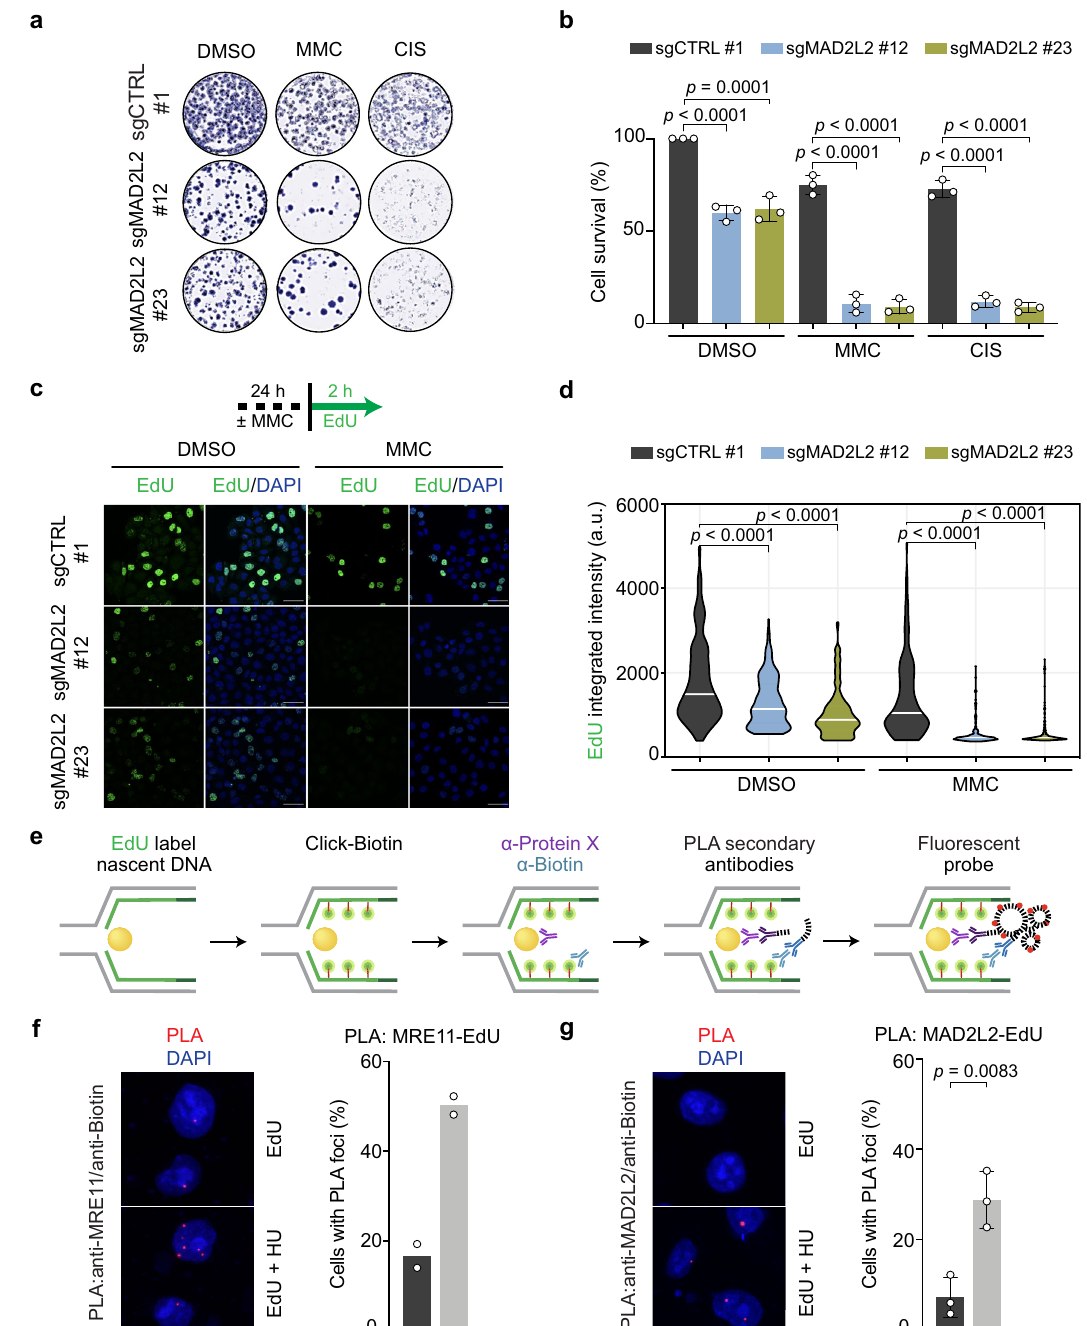
Fig. 1 | MAD2L2 promotes global DNA replication during replicative stress. a, b Representative images ( a ) and quanti fi cation ( b ) of survival assays in control (sgCTRL)andMAD2L2-depletedHeLacells,untreatedortreatedwith0.5 μΜ MMC or 1 μΜ CIS. Bars represent the mean±SD. Each dot represents one of three independentexperiments.Statisticalanalysiswasperformedaccordingtoone-way ANOVA with Dunnett ’ s multiple comparisons test. c, d Assessment of DNA synth- esis rates. Schematic with representative images ( c ) and quanti fi cation ( d ) of EdU incorporationintensityincontrol(sgCTRL)andMAD2L2-depletedHeLacells.Cells were incubated with or without 5 μΜ MMC for 24h, followed by EdU labeling for 2h before harvesting. Scale bar, 50 μΜ . White bars represent the median of three